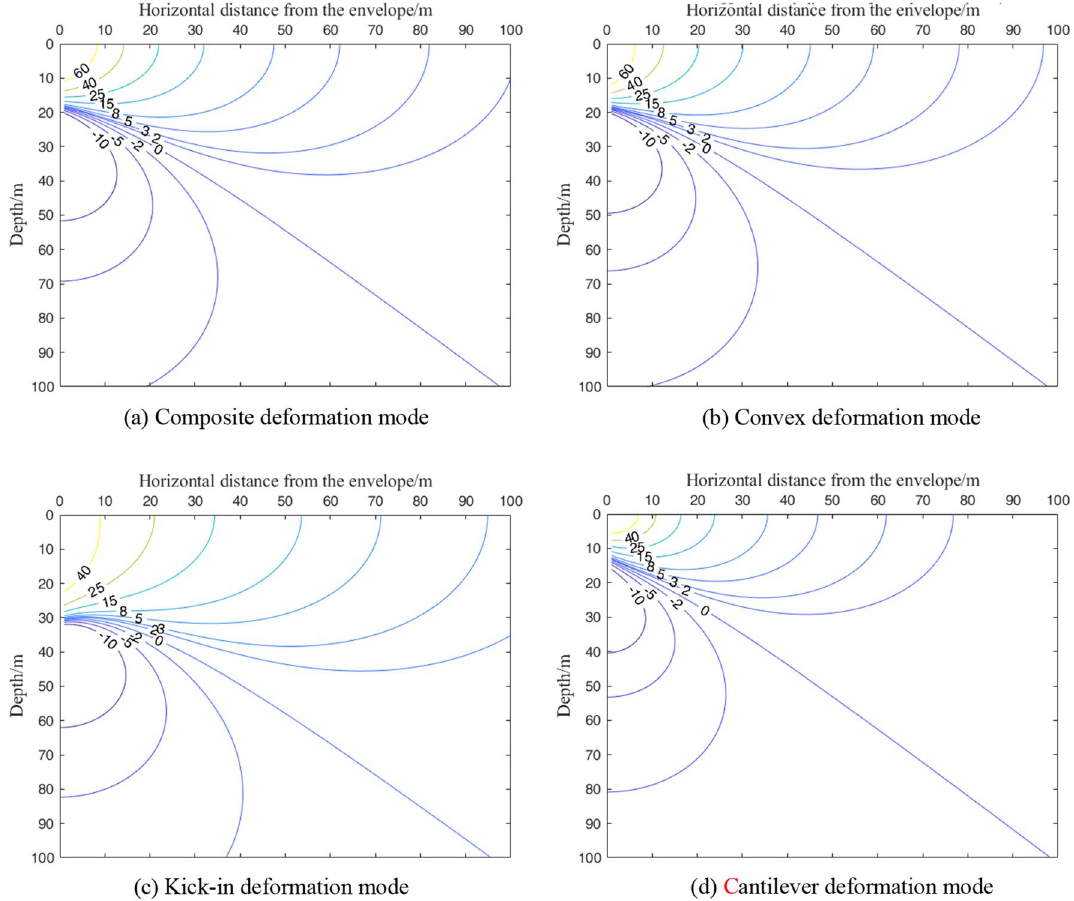
Figure 9. Vertical displacement field of soil caused by different deformation modes of retaining